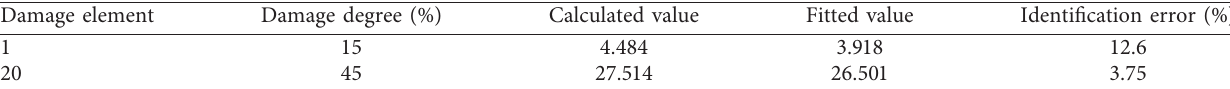
Table 6: Validation of multidamage degree function